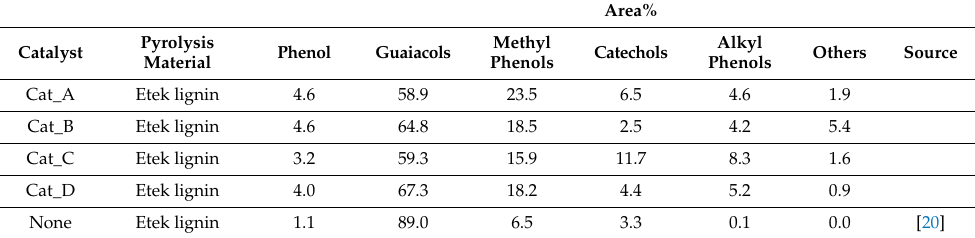
Table 3. Phenol distribution of bio-oil products obtained from GC-MS